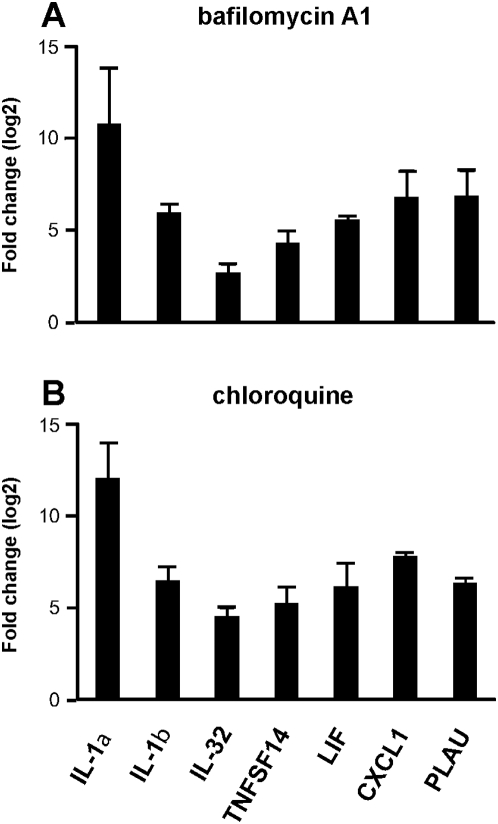
Role of alkalinization on the inflammatory signature of wt TG cells.Wild type TG cells were treated with 300 nM bafilomycin A1 (A) or 200 µM chloroquine (B) for 3 h. The expression levels of the seven genes involved in the inflammatory signature of CF-TG cells were studied by qRT-PCR. Results are expressed as the log2 ratio of the fold change observed in the presence of alkalinization agent vs. in its absence. They represent the means±SEM of three experiments.